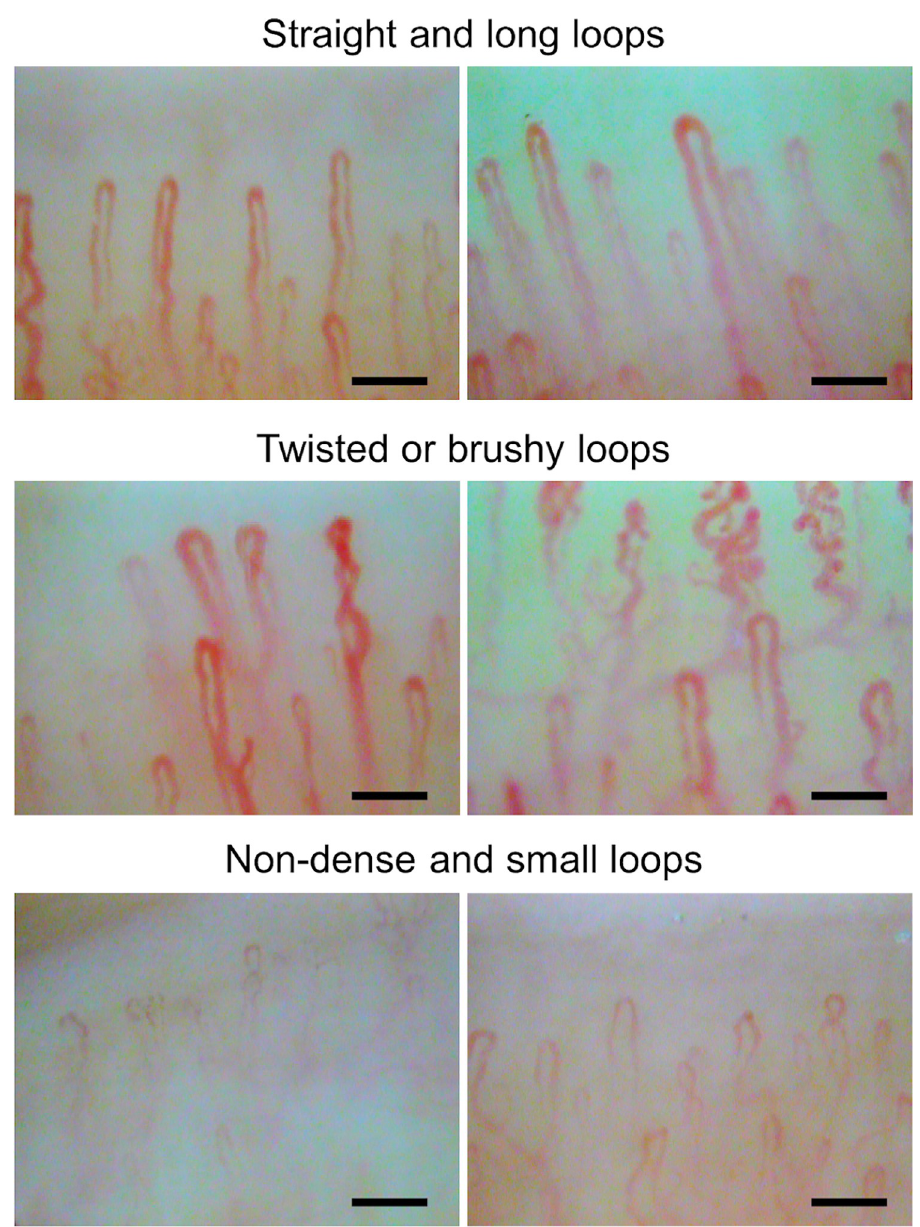
Fig 4. Representative pattern of nailfold capillaries. Representative images of nailfold capillaries showing straight and long loops, twisted or bushy loops, and non-dense and small loops. Scale bars: 100 μ m.